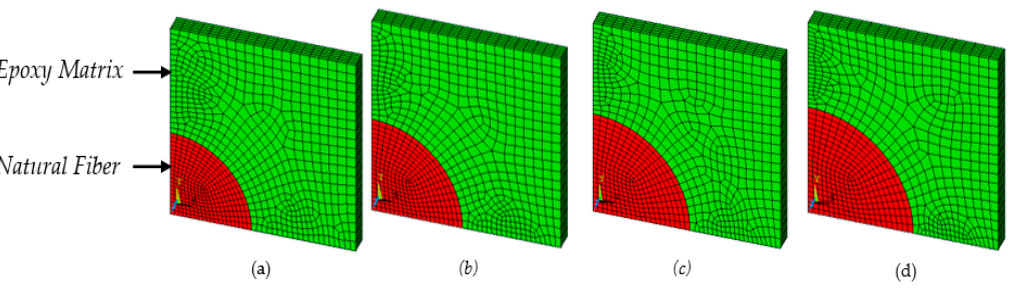
Figure 4. Converged mesh models of composite (RVE dimension) at: ( a ) 15 %; ( b ) 18 %; ( c ) 21 % and ( d ) 24% of volume fraction of natural ( d ) 24 % of volume fraction of natural fibers.